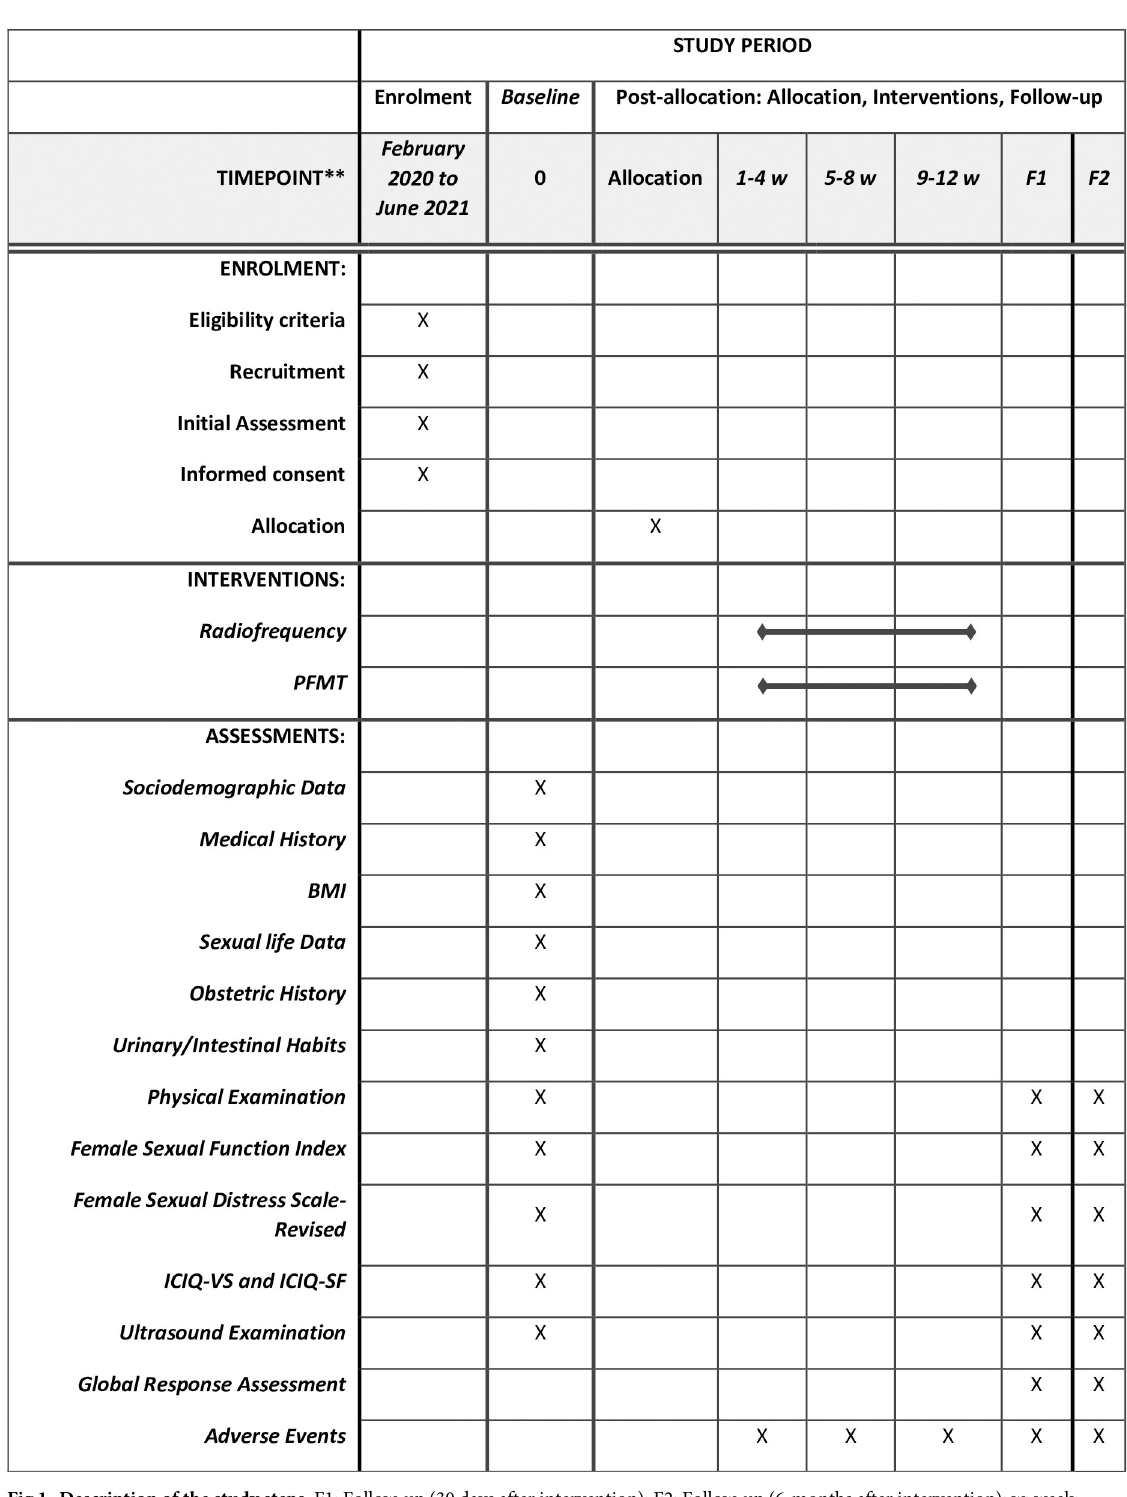
PLOS ONE | https://doi.org/10.1371/journal.pone.0259650 November9,